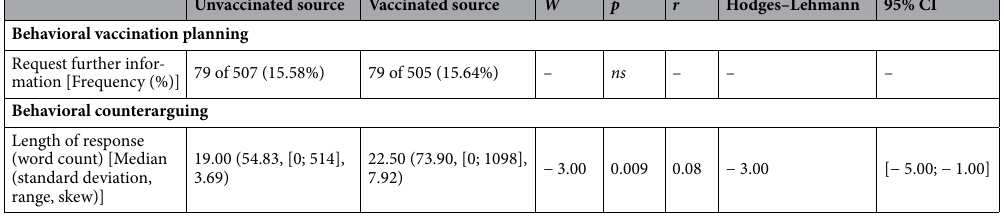
Table 2. Behavioral measures by comment source (collapsed across participant vaccination